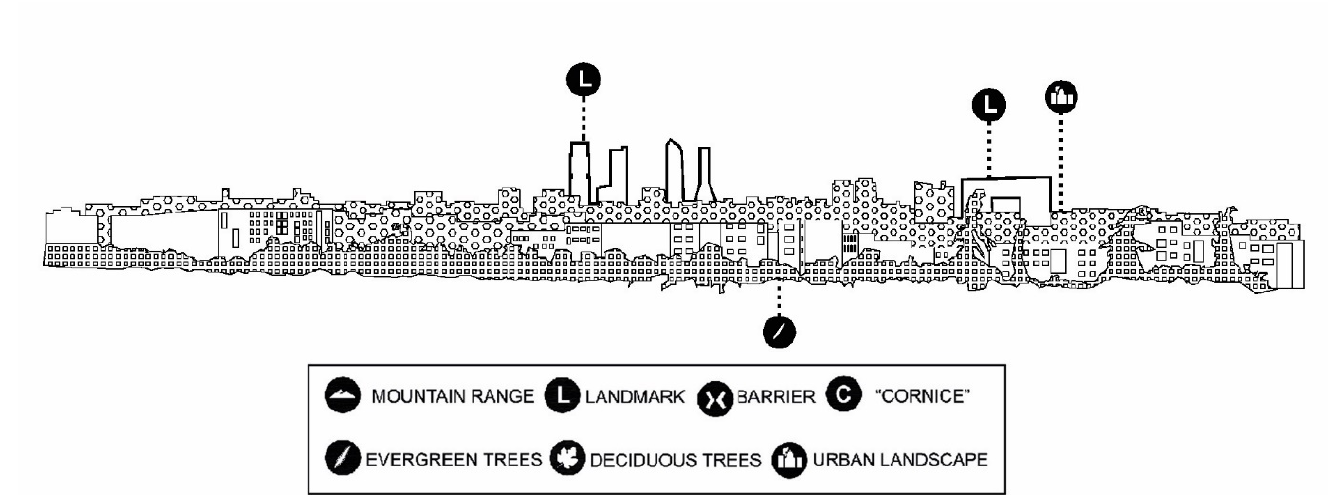
Figure 6: Interpretive drawing of the view from Felipe IV Park